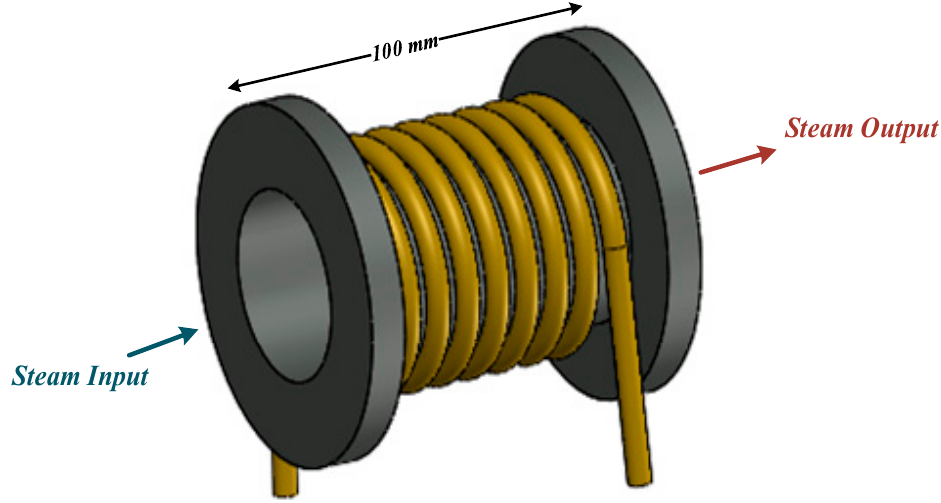
Figure 4. Structure of heating objects typically employed in the cleaning process.